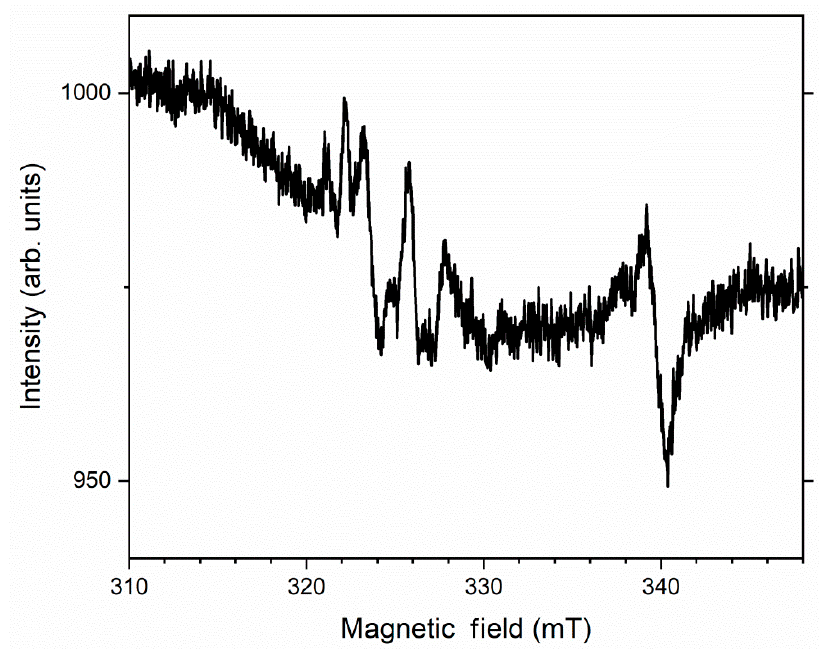
Figure 9. ESR spectrum of nosean (Sample 7) measured at 77 K.